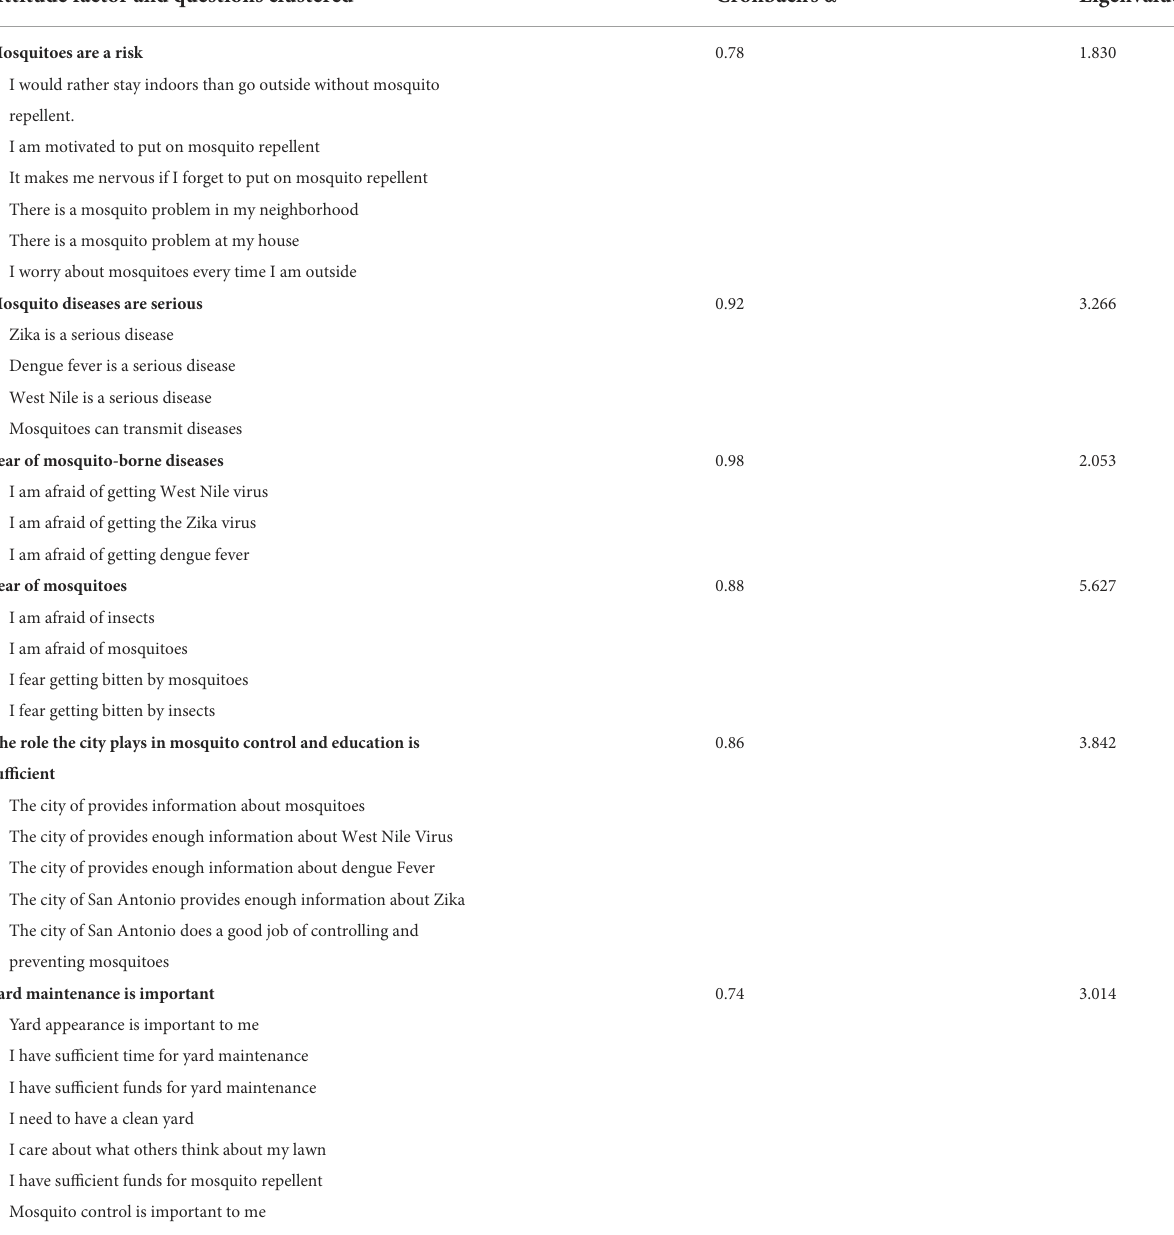
TABLE 2 Attitude scale factor analysis and